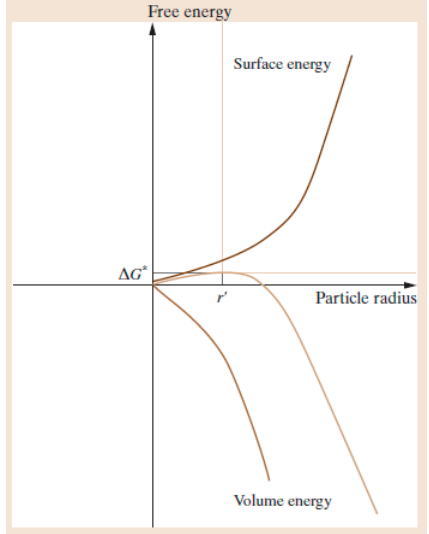
Figure 1. Free energy of the nucleation [21]. With permit of the copyright (Copyright Clearance Center License 4635650204890). Reproduced with permission from Springer Handbook of Crystal Growth ;